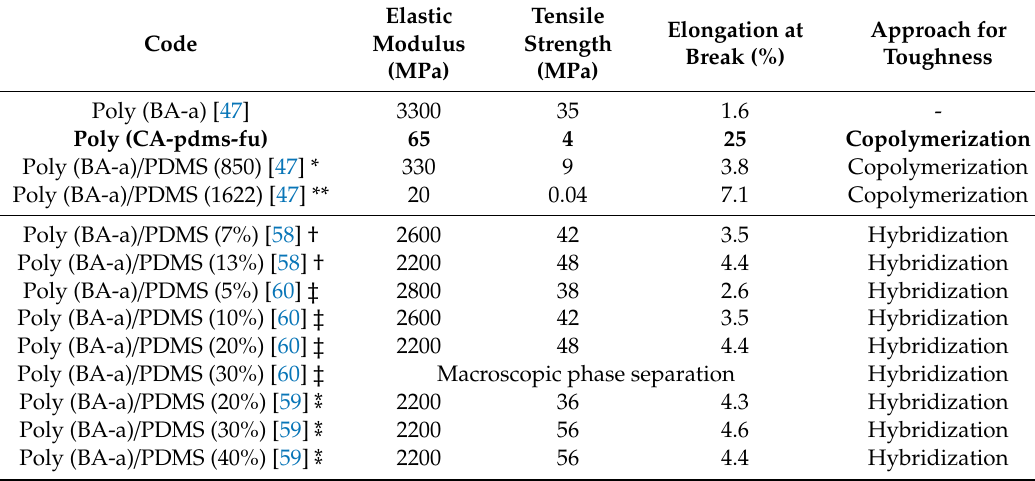
Table 1. Tensile Properties of polybenzoxazine containing PDMS.